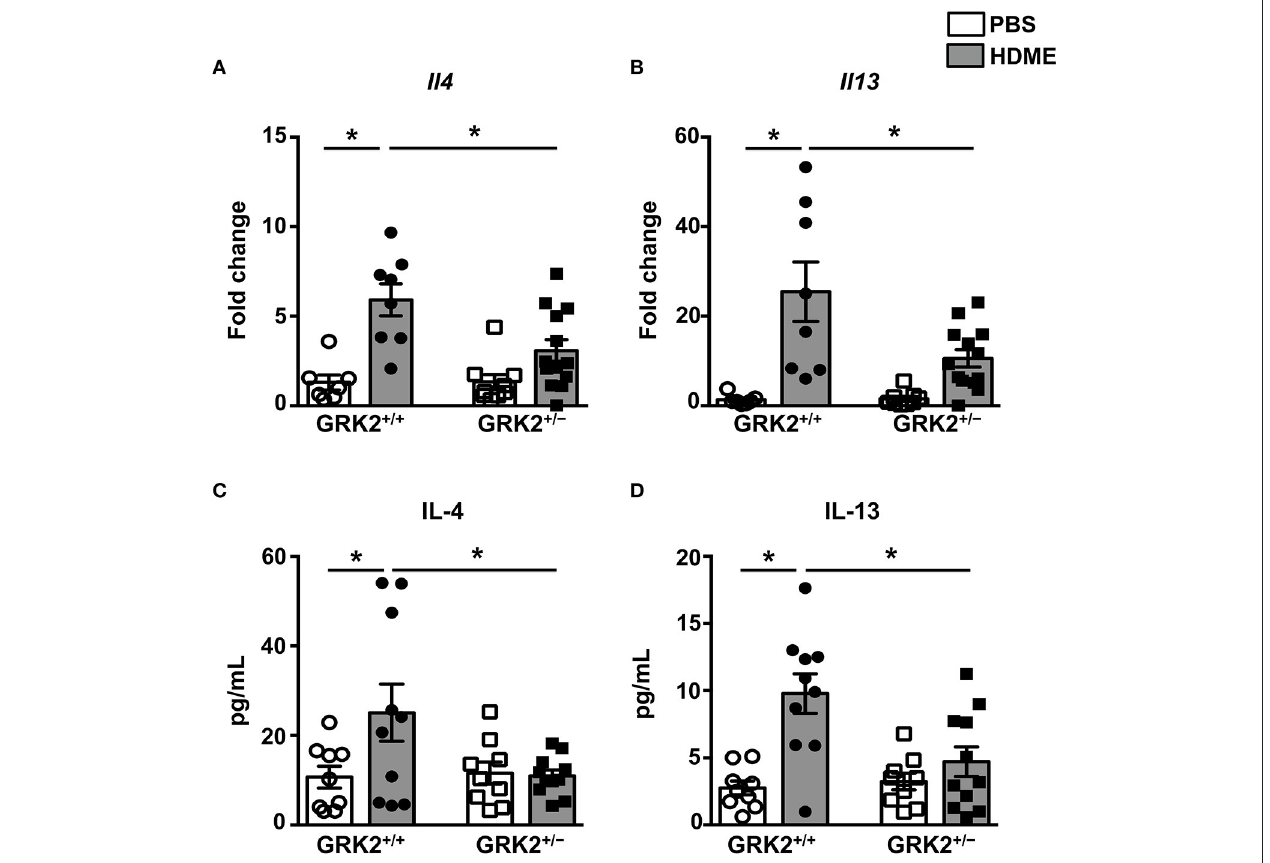
FIGURE 3 | IL-4 and IL-13 levels in the lungs and BALF are reduced in GRK2 + / − mice exposed to HDME. PBS control or HDME-exposed GRK2 + / + and GRK2 + / − mice were euthanized after the last HDME challenge. (A,B) Lungs samples from these mice were analyzed for mRNA expression of Th2 cytokines [ (A) Il4 and (B) Il13 ]. (C,D) BALF was harvested from these mice and (C) IL-4 and (D) IL-13 cytokine levels were determined. Data are presented as mean ± SEM and are pooled from 2 to 3 independent experiments with a total of 7–13 male and female mice per cohort. Statistical significance was determined Student’s unpaired t -test. * p ≤